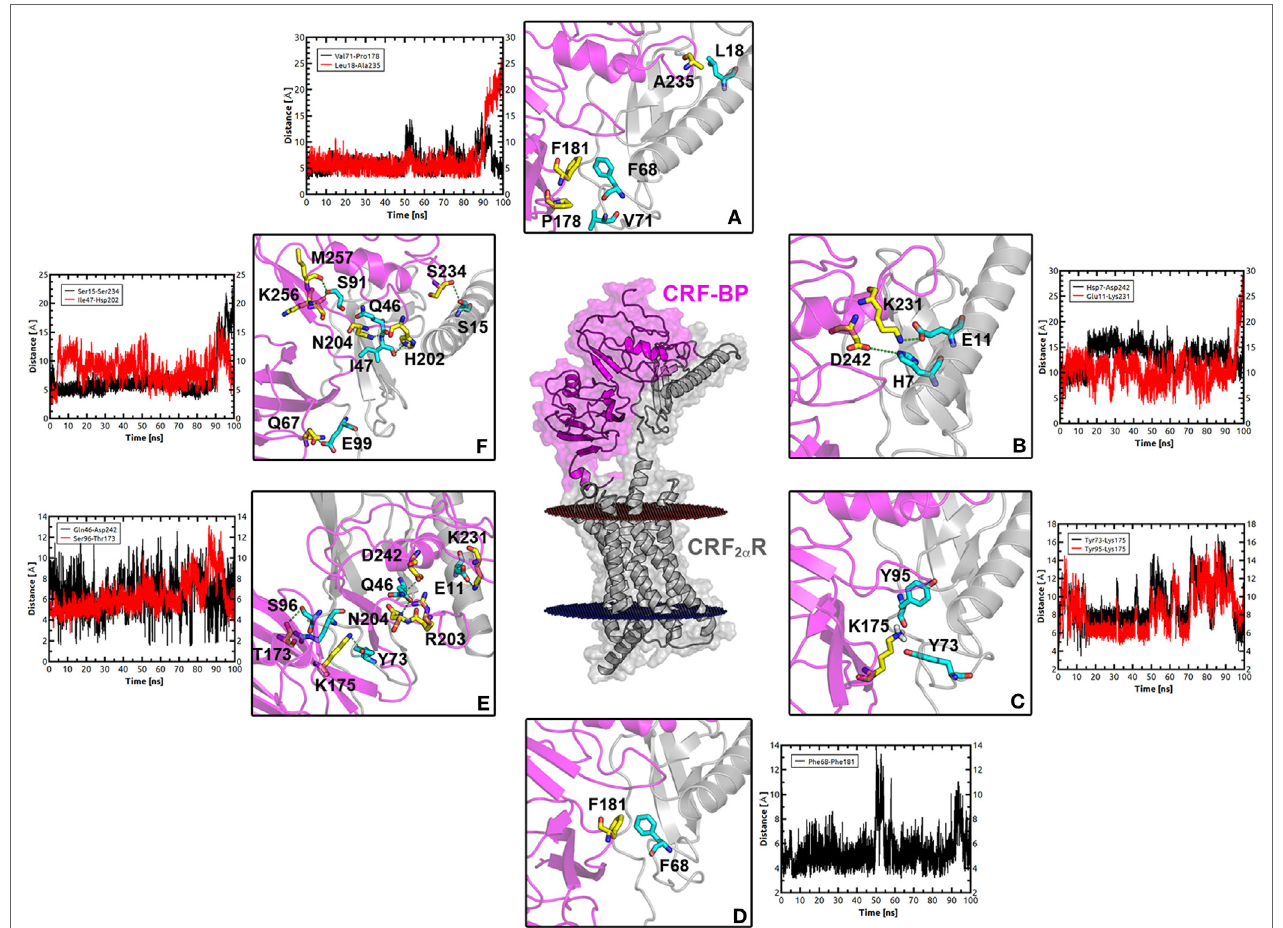
FigUre 8 | Interacting interface between CRF-BP and CRF 2 α R. (a–F) Magnifications of the interacting interface of CRF-BP with CRF 2 α R, showing different kinds of interactions determined using the protein interaction server. Hydrophobic interactions (a) , ionic interactions within 6 Å (B) , cation– π interaction within 6 Å (c) , aromatic-aromatic interactions within 4.5–7 Å (D) , protein–protein side chain hydrogen bonds (e) , and protein–protein main chain hydrogen bonds (F) . The measurement of these interactions was followed during a 100 ns molecular dynamics simulation of the CRF-BP/CRF 2 α R predicted